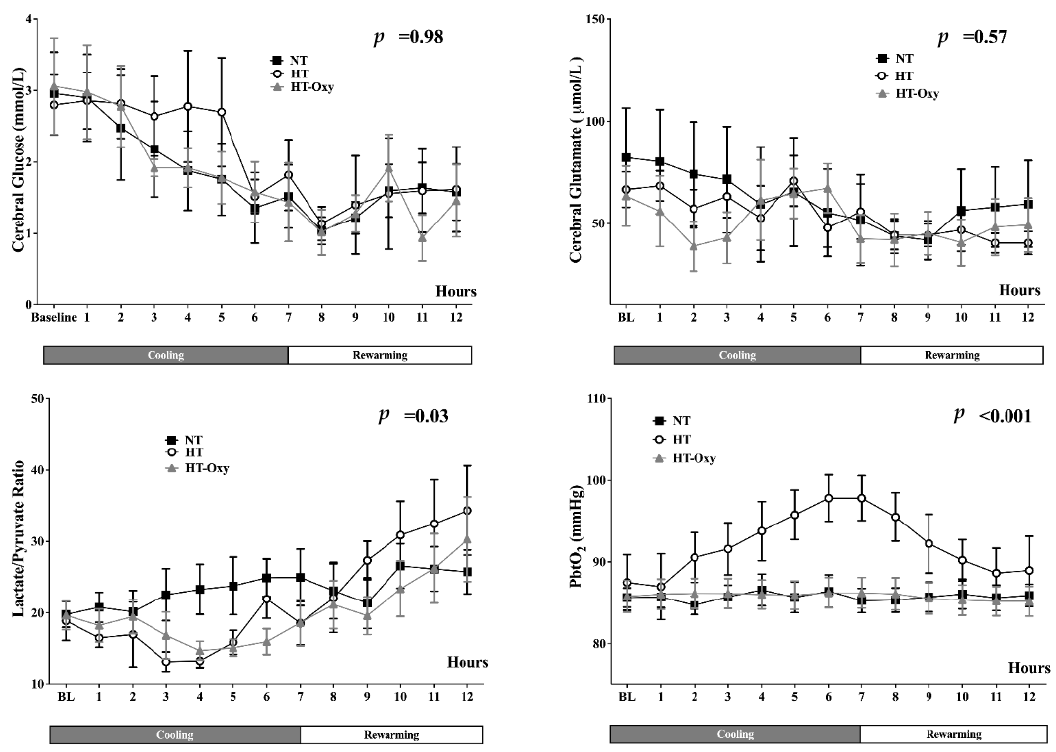
Figure 3. Time-course of cerebral glucose, glutamate, lactate/pyruvate ratio and brain oxygen pressure (PbtO 2 ) in the normothermia (NT), hypothermia (HT) and hypothermia with PaO 2 levels kept constant with baseline values (HT-Oxy). p -value indicated differences over time between groups.